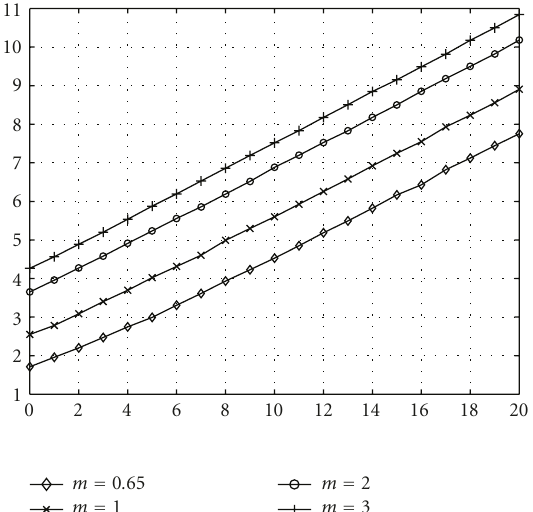
Figure 2: UWB multipath fading channel capacity with L = 10.